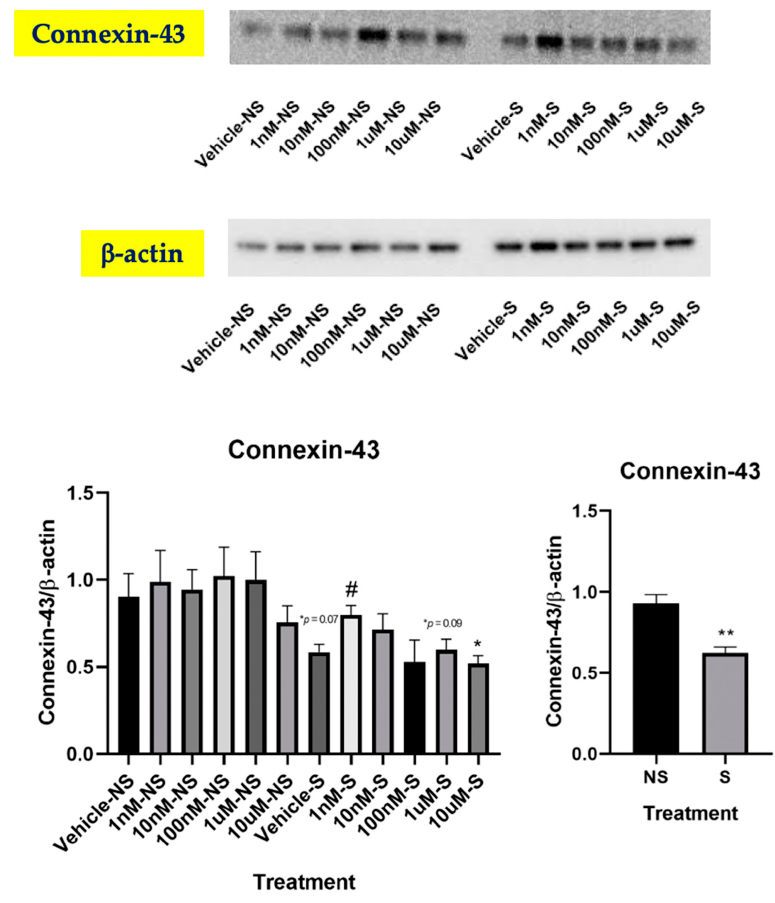
Figure 5. E ff ects of lycopene treatment at 1 nM, 10 nM, 100 nM, 1 µ M and 10 µ M for 24 h on Cx43. Graphic representation of fold changes in the protein expression of Cx43. Three replicates were used for statistical analysis. Values are means ± SEMs. NS—cells not exposed to smoke; S—cells exposed to smoke; cells treated with vehicle. Student’s t test was used to compare protein expressions between lycopene-treated cells and vehicle-treated cells; * indicates significance at p < 0.05 compared with the cells not exposed to smoke treated with vehicle; # indicates significance at p < 0.05 compared with smoking. Two-way ANOVA was used to compare protein expressions between the cells exposed to smoke and the cells not exposed to smoke; ** indicates significance at p < 0.01 compared with the cells not exposed to